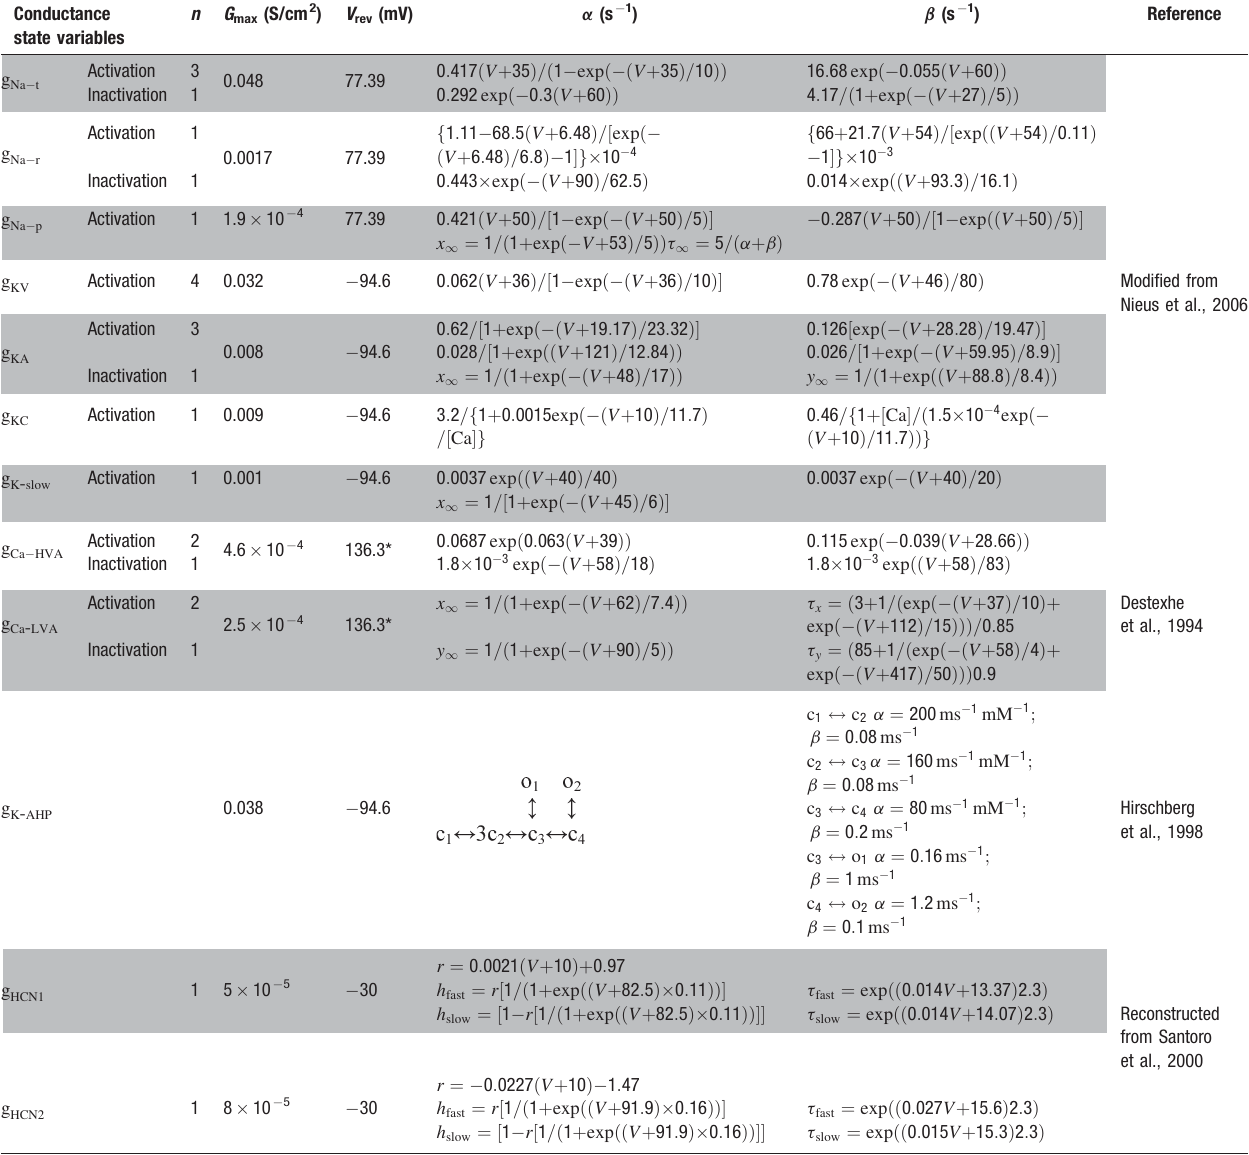
Table 1. Voltage-dependent conductance parameters. Conductance state